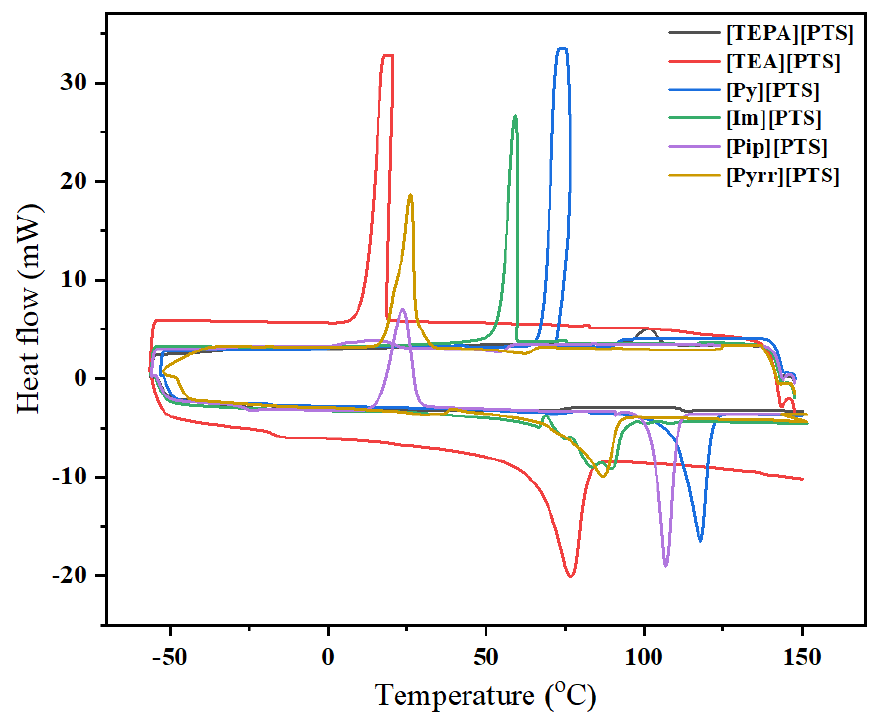
Figure 4. DSC thermogram of the p-toluene sulfonic acid [PTS] anion based protic ionic liquids. Table 2. Important thermal properties of the p-toluene sulfonic acid [PTS] anion based protic ionic liquids (PILs).